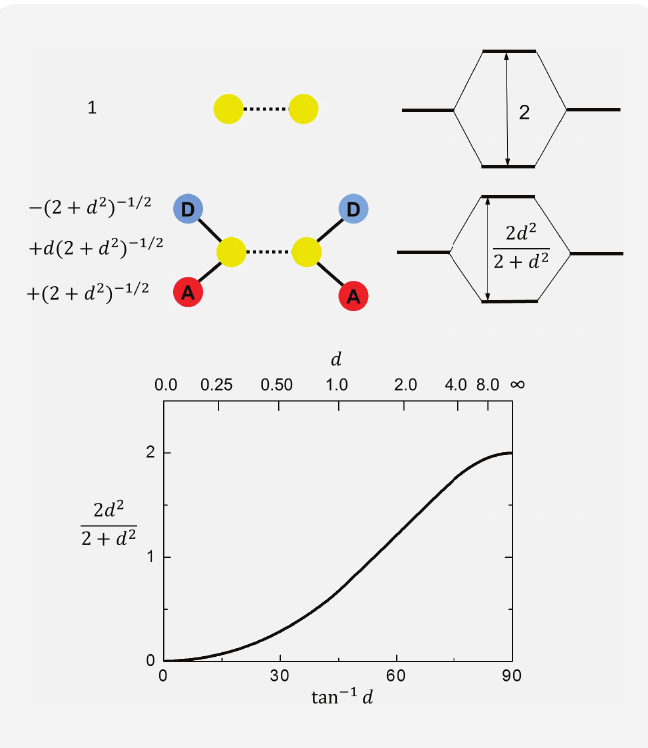
Figure 6. Decrease of the HOMO-LUMO gap of ethylene upon captodative substi- tution. D = donor, A = acceptor, of equal strengths d. Left, coeffi cients of the non- bonding MO before pi interaction is introduced. Right, HOMO-LUMO gap in units of the resonance integral beta. Bottom, the HOMO-LUMO gap as a function of